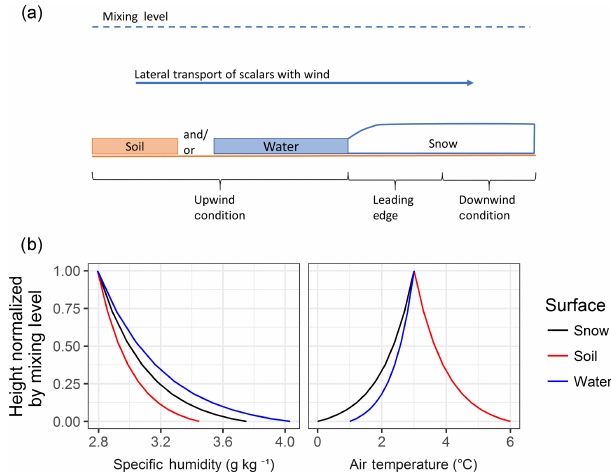
Figure 1. (a) Conceptual cross section of the advection process dur- ing snowmelt and (b) conceptual specific humidity and air tempera- ture profiles between snow (0 ◦ C, 100% RH), soil (6 ◦ C, 60% RH) and water (1 ◦ C, 100% RH) surfaces and the mixing height (3 ◦ C, RH of